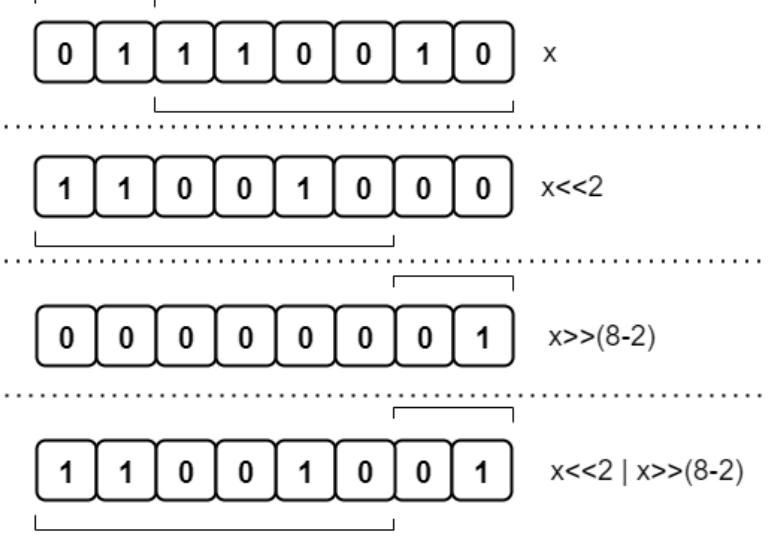
Figure 4. Example of a circular shift